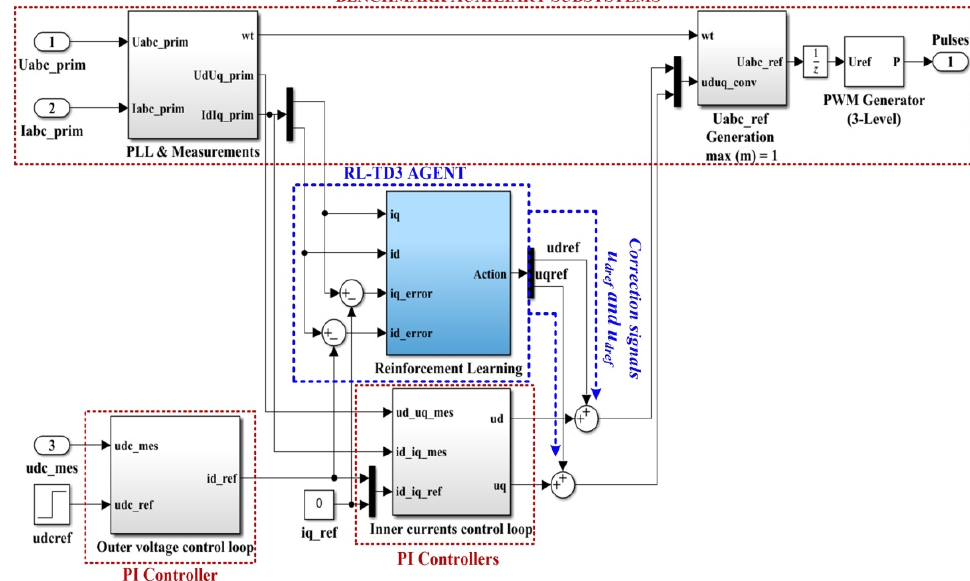
Figure 11. The model MATLAB Simulink implementation of the control system for the GC-PV array based on PI controllers using the RL-TD3 agent for the correction of the u dref and u qref commands.